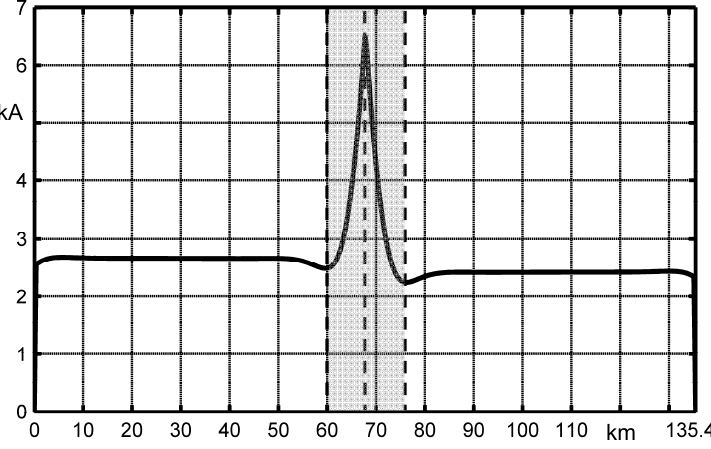
| along the line in fault EW